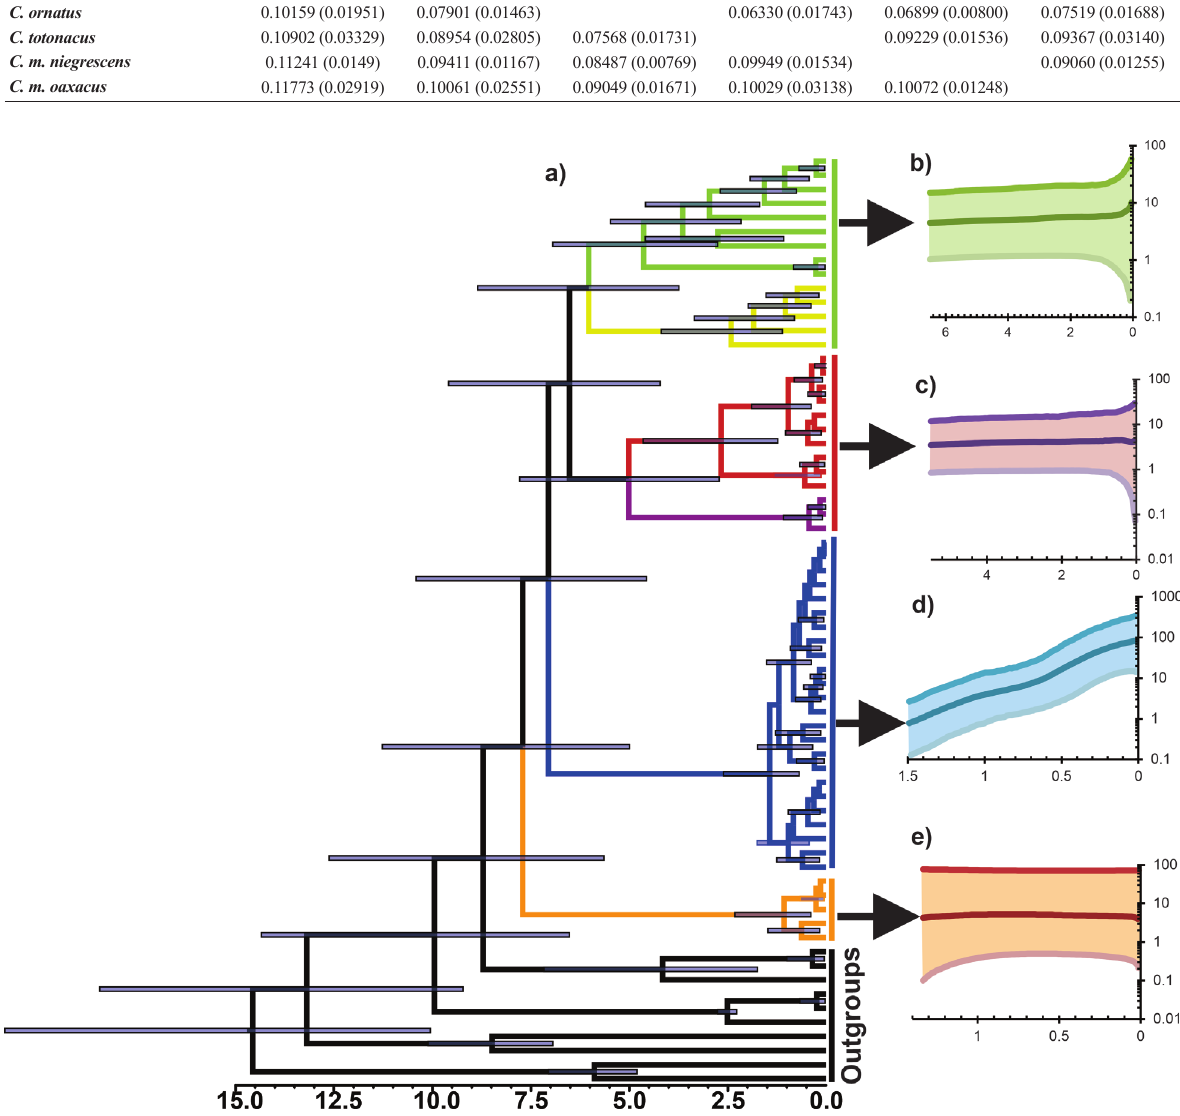
Figure 4. a. Bayesian divergence time estimation among black-tailed rattlesnake populations based on the 3-mtDNA dataset. Colored clades are indicated as follows: C. basiliscus , green; C. m. molossus , yellow; C. ornatus , red; C. totonacus , purple; C. m. nigrescens , blue; C. m. oaxacus , orange. Skyride reconstructions for the following main condensed lineages; b. C. m. molossus + C. basiliscus ; c. C. ornatus + C. totonacus ; d. C. m. nigrescens and e. C. m. oaxacus lineages (see the Materials and Methods